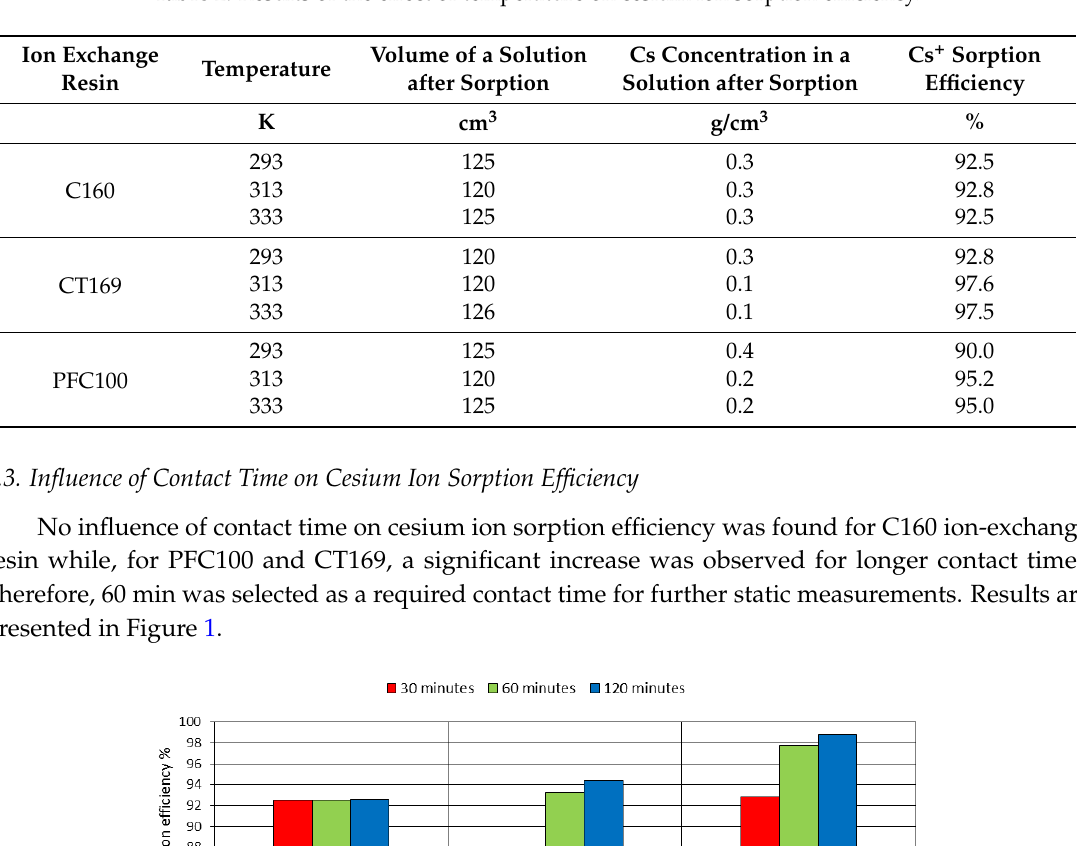
Table 2. Results of the effect of temperature on cesium ion sorption efficiency.